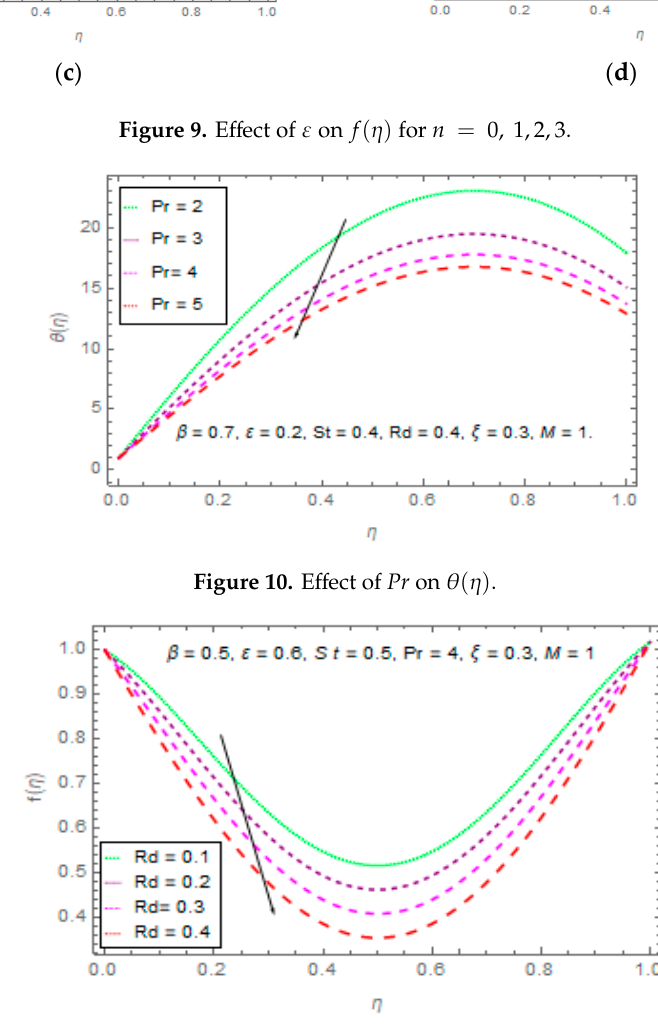
ff ect of Rd on θ ( η ) Figure 11. Effect of 𝑅𝑑 on 𝜃(𝜂) . Figure 11. E Figure 11. Effect of 𝑅𝑑 on 𝜃(𝜂) . Figure 11. Effect of 𝑅𝑑 on 𝜃(𝜂) .